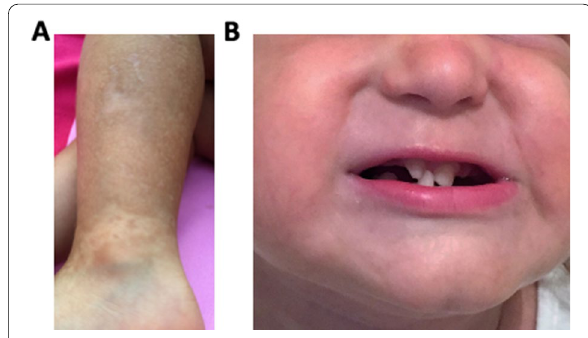
Fig. 3 Picture of the patient. A. Hyperpigmented lesions on legs, B. Cone-shaped teeth and partial